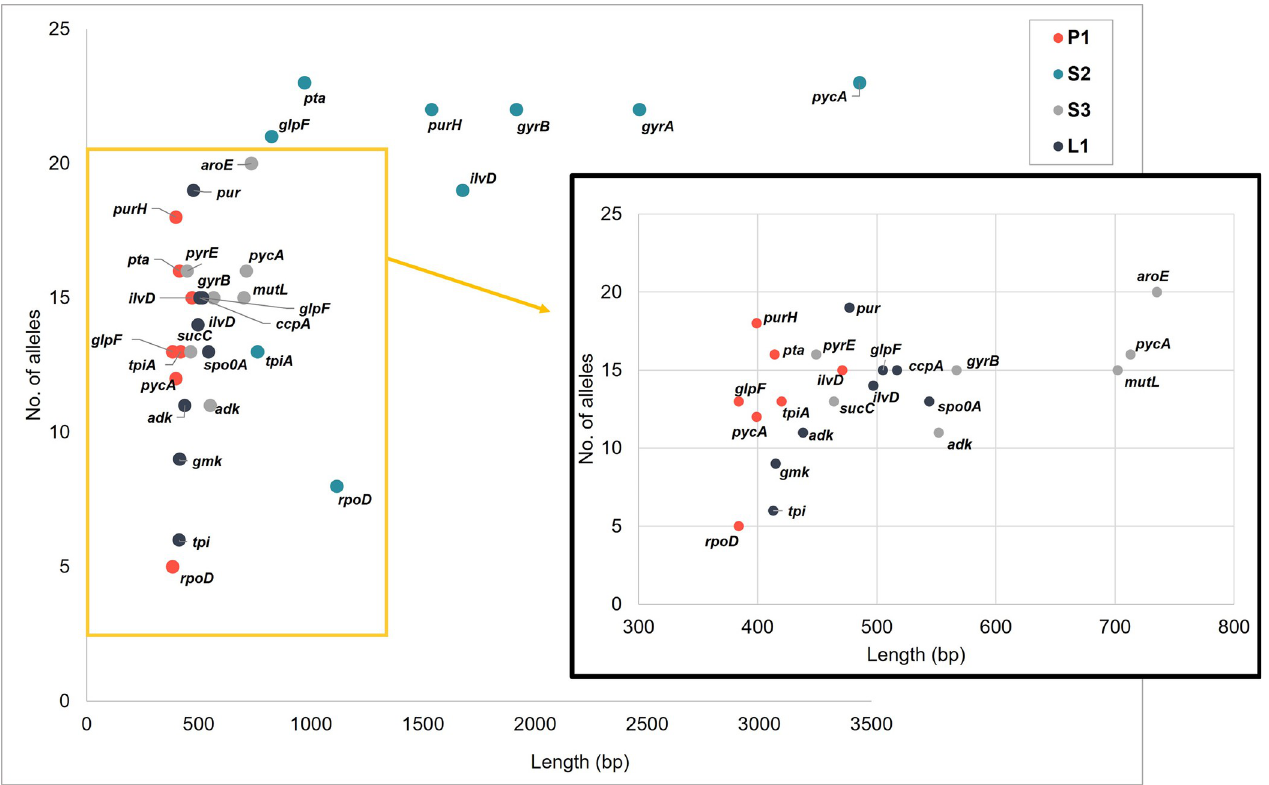
Fig 1. Scatterplot comparing genes used in multilocus sequence typing (MLST) methods for Bacillus subtilis . Comparison of housekeeping gene lengths and variability in terms of number of alleles for 39 strains of B . subtilis .